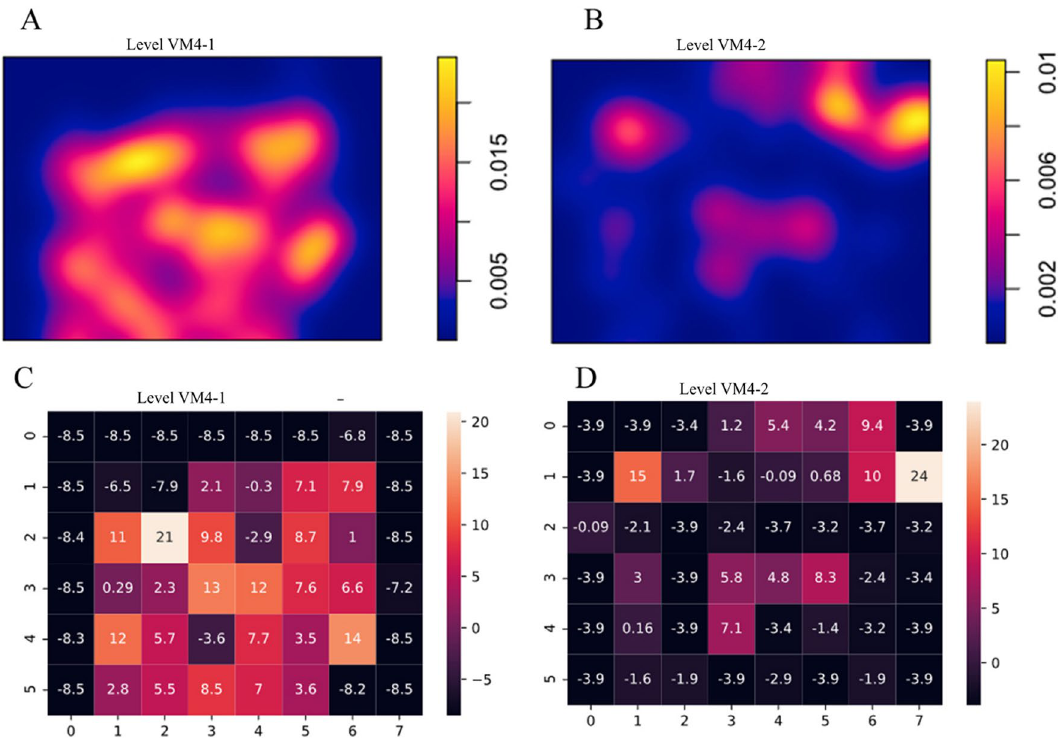
Figure 3. Density ( A , B ) and heat ( C , D ) maps for Pearson residual counts (for each of the level VM4-I ( A , C ) and VM4-II ( B ,